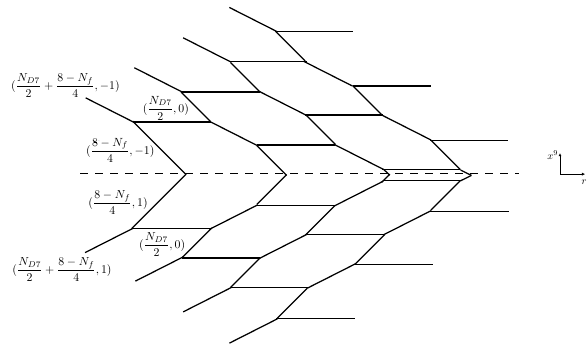
Figure 3 . 5-brane web consistent with the quantised charges of the non-Abelian T-dual solution. The dashed line represents the branch-cut created by the D7/O7 branes at each r 2 [ p(cid:25); ( p + 1) (cid:25) ] interval. At each interval a new, smeared, D7/O7 brane system adds to the discontinuity in the 5-brane charge created by the branch